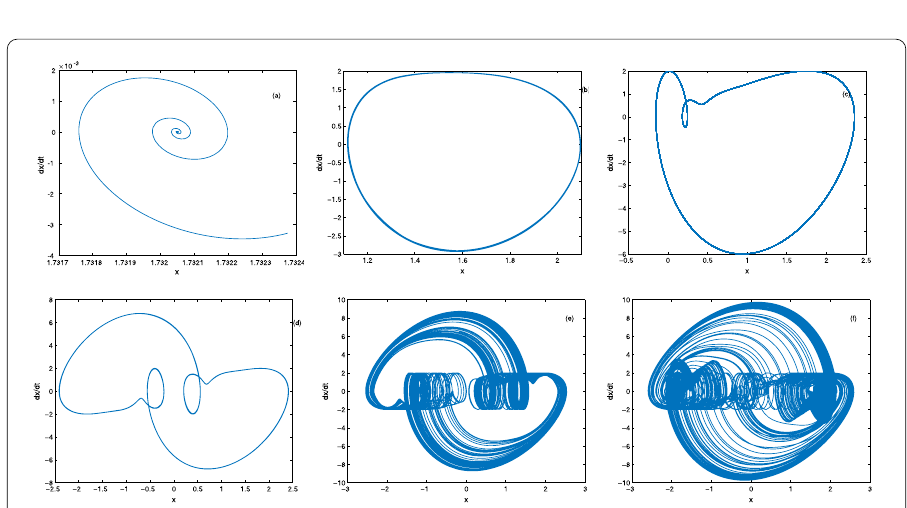
Figure 13 The phase plane plot in x – dx / dt space for different τ : ( a ) τ = 0.17 (stability), ( b ) τ = 0.3 (period-1), ( c ) τ = 0.43 (period-2), ( d ) τ = 0.46 (period-4), ( e ) τ = 0.52 (chaos), ( f ) τ = 0.55 (chaos) with parameter γ =